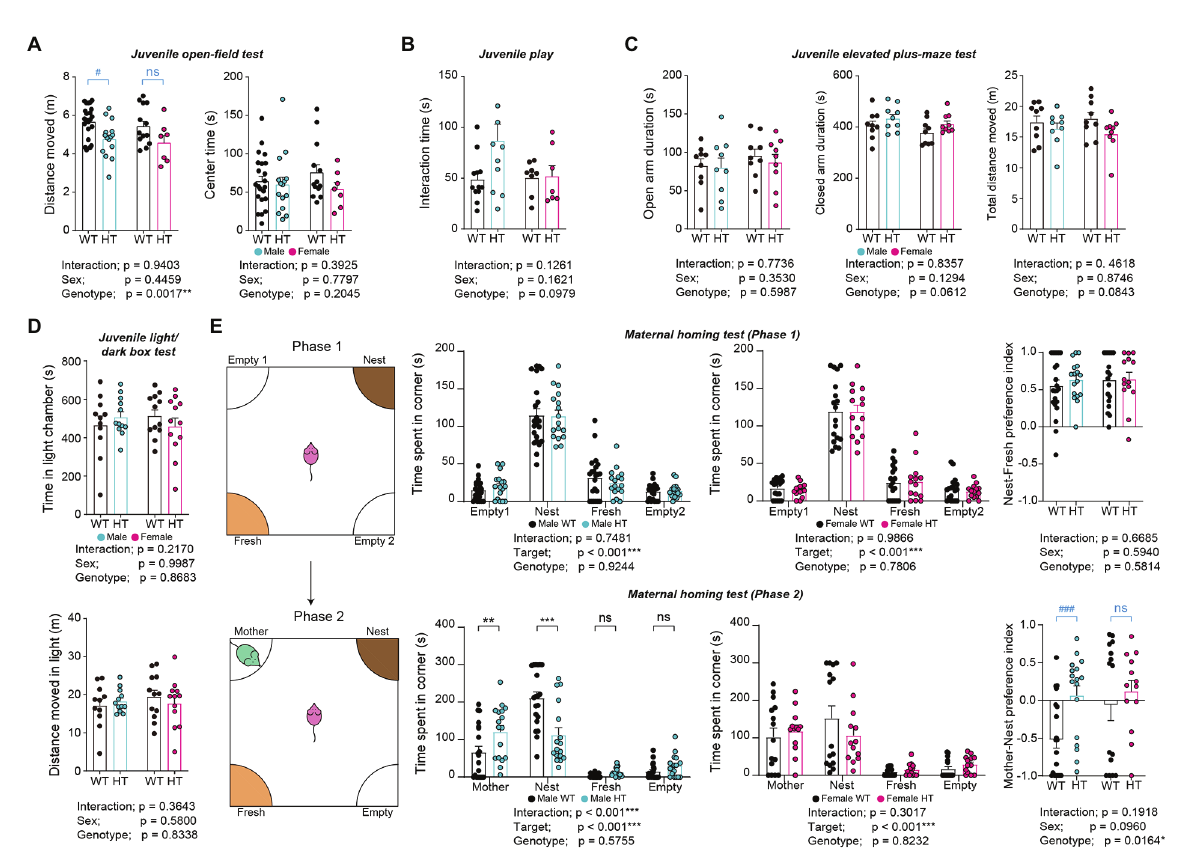
FIGURE 3 Hypoactivity and enhanced mother-seeking/attachment behavior in male but not female Chd8 +/S62X juveniles. (A) Juvenile male and female Chd8 +/S62X mice (P24) show genotype-dependent decreases in the locomotor activity in the open-field test compared with WT